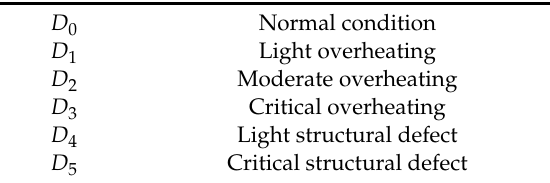
Table 4. Technical states of the turbojet engine.